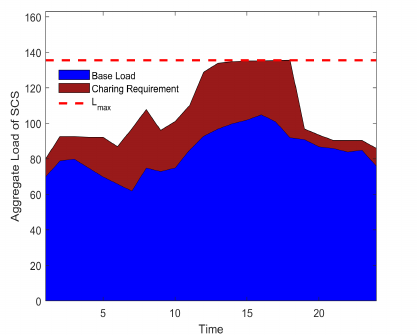
Figure 7. Charging strategies for 10 PEVs with overload